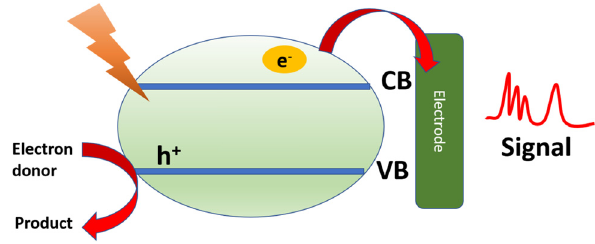
Figure 12: Schematic sketch of TiO 2 - based PEC